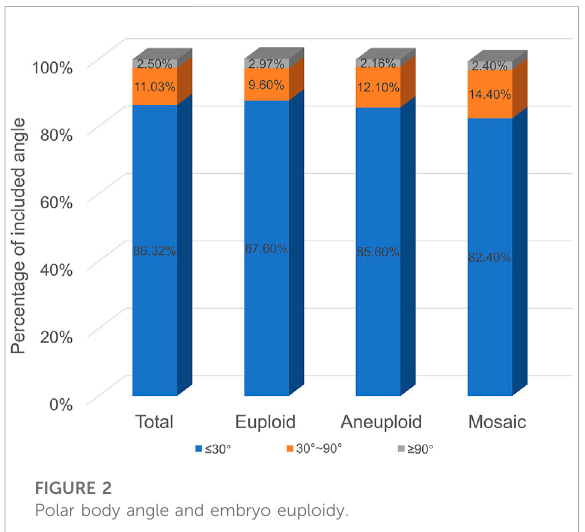
FIGURE 2 Polar body angle and embryo